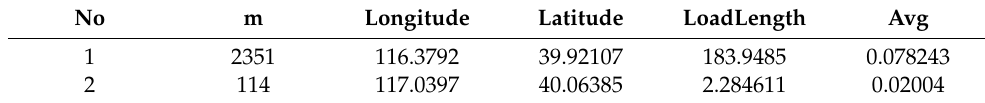
Table 14. The clustering results of the algorithm in this paper for the DS3 dataset.